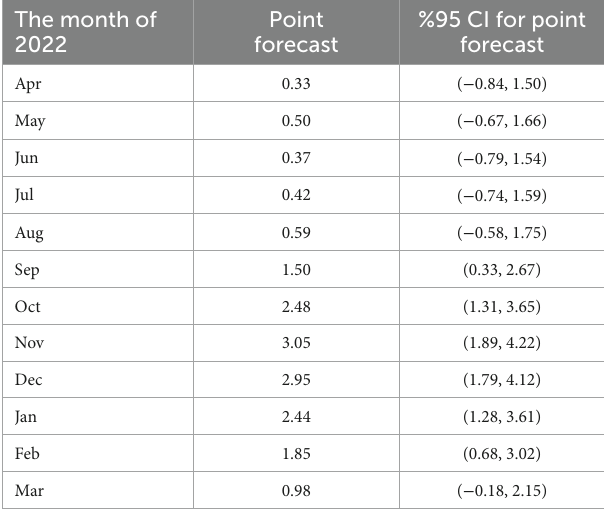
TABLE 5 Prediction of cutaneous leishmaniasis incidence based on 95% CI for point forecast, 2022. The month of 2022